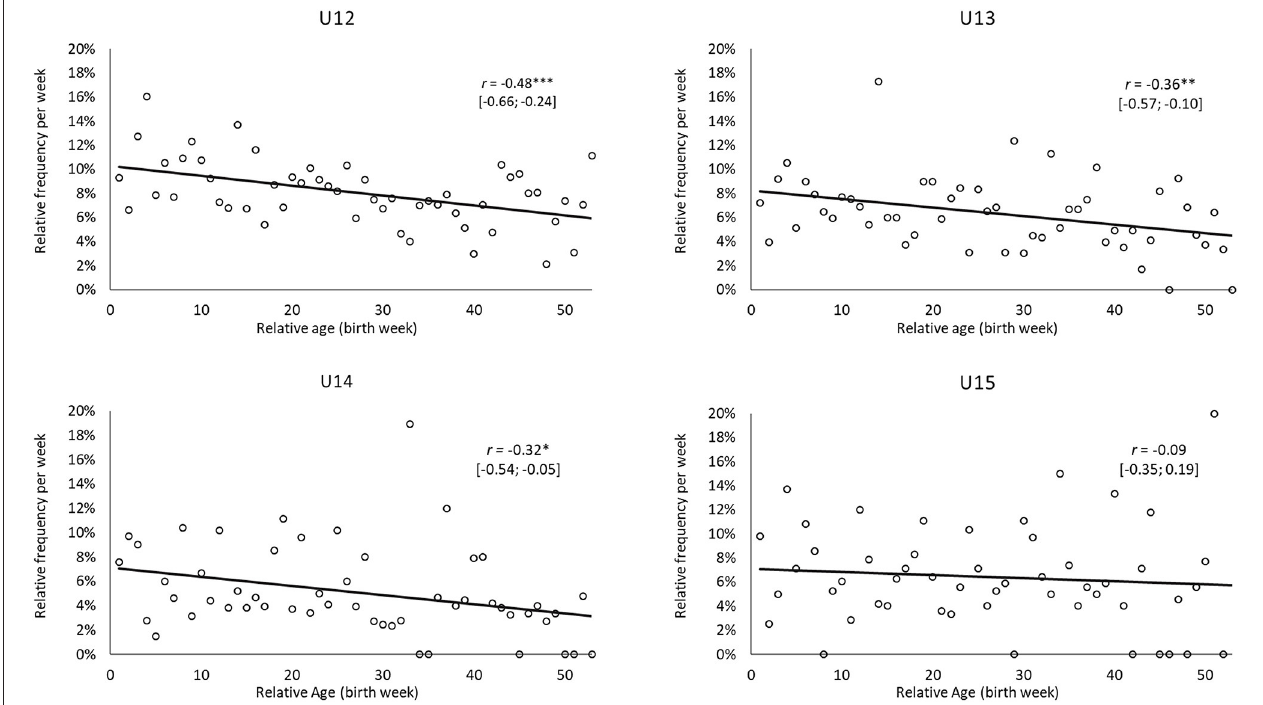
FIGURE 4 | Relative frequencies for holistic ratings of future performance per week of birth for players whose future performance was assigned to the professional level (League 1–3) by coaches for the age groups U12 to U15. p < 0.05; ** p < 0.01; and *** p <